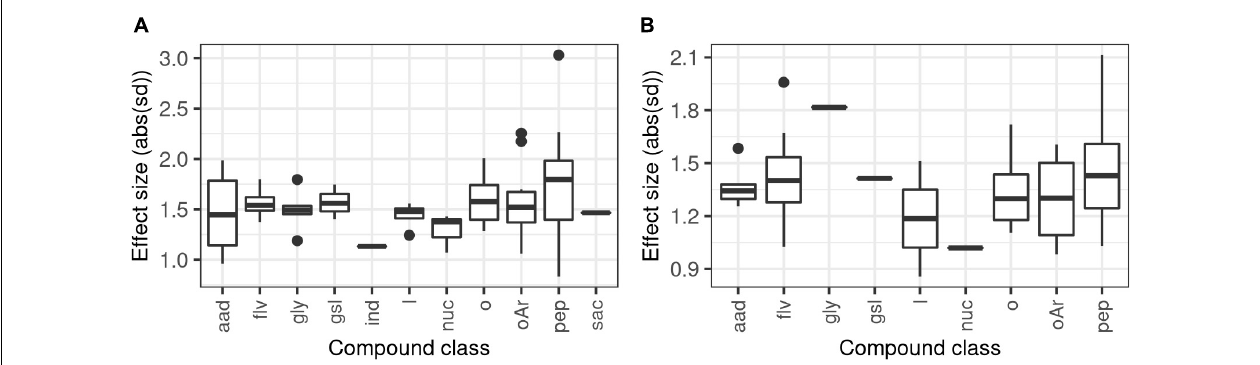
FIGURE 3 | Effect size comparison of various metabolite classes, obtained from statistically significant correlations between logratio-transformed fungal abundance (proportion) data and core chemical feature abundance data. Phenomena were considered significant at p < 0.05 after Benjamini–Hochberg adjustment of p -values for all statistical tests. Effect size is defined as the difference of the fungal abundance data between the first and fourth quartile of the chemical data, expressed as absolute value of standard deviations. Subplots: (A) phenomena at order level resolution; (B) phenomena at genus level resolution. aad, amino acids and derivatives; flv, flavonoid glycosides; gly, glycosides; gsl, glucosinolates; ind, indole derivatives; l, lipids and lipid-like compounds; nuc, nucleotide derivatives; o, other compounds (unknown or non-annotated); oAr, other aromatic/polyphenolic compounds; pep, peptides; sac,